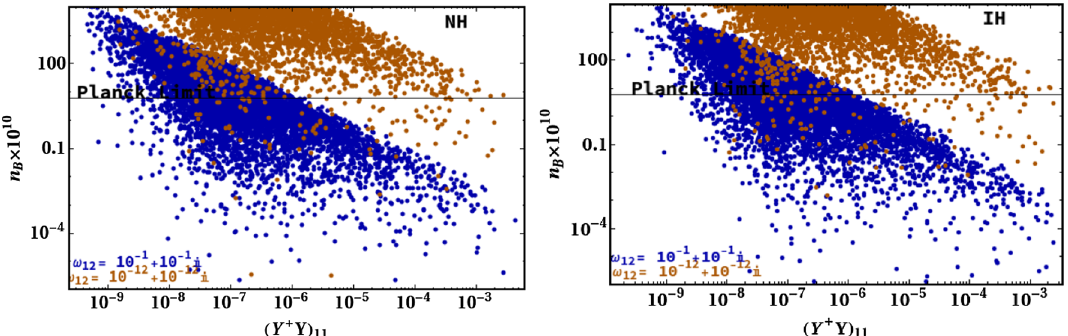
Fig. 3 Yukawacouplingterm YY † asafunctionofBAUfortwodifferentvaluesofarbitraryangle ω 12 andbenchmarkvaluesof ω 13 = 10 − 3 + 10 − 3 i 11 and ω 23 = 10 − 2 + 10 − 2 i for